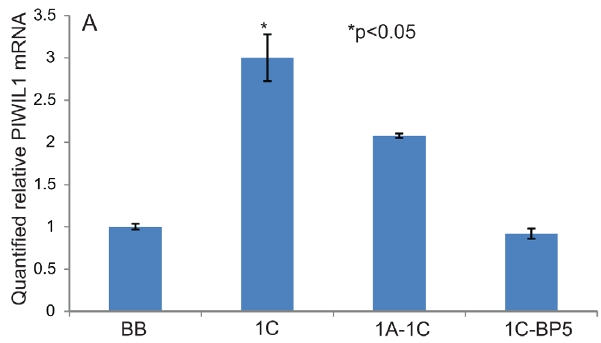
Figure 7 . Effect of RASSF1C-IGFBP5 interaction on PIWIL1 mRNA expression . Piwil1 mRNA expression was assessed in H1299 cells stably transduced with MLV-HA-back bone (BB), MLV-HA-RASSF1C (1C), MLV-HA-RASSF1A and 1C (1A-1C) and MLV-HA-1C and IGFBP-5 (1C-BP5). RT-PCR data show that piwil1 mRNA expression in cells co- expressing 1C and BP5 was reduced compared to cells over-expressing 1C and 1A and1C. Data is representative of at least 3 independent experiments, and the values represent the mean 6 SEM. * P , 0.05: for 1C compared to BB.